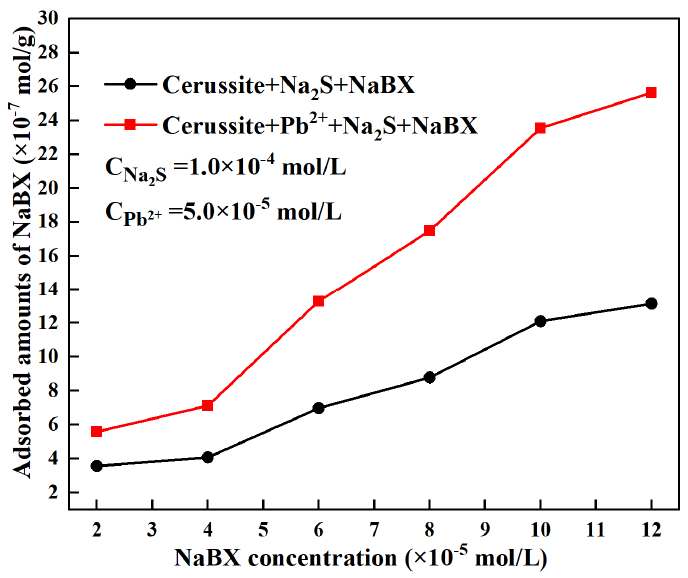
Figure 4. Amounts of NaBX adsorbed on cerussite surfaces as a function of NaBX concentrations before and after Pb 2+ addition.